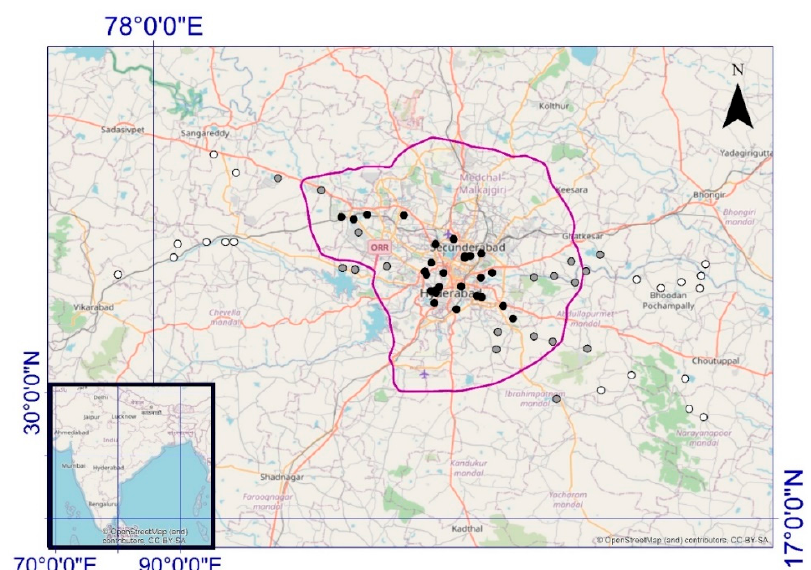
Figure 1. Rural (white), peri-urban (grey) and urban (black) study locations in Telangana State, India. The Nehru ring road is shown in purple. Inset is a wider map showing Hyderabad within India.